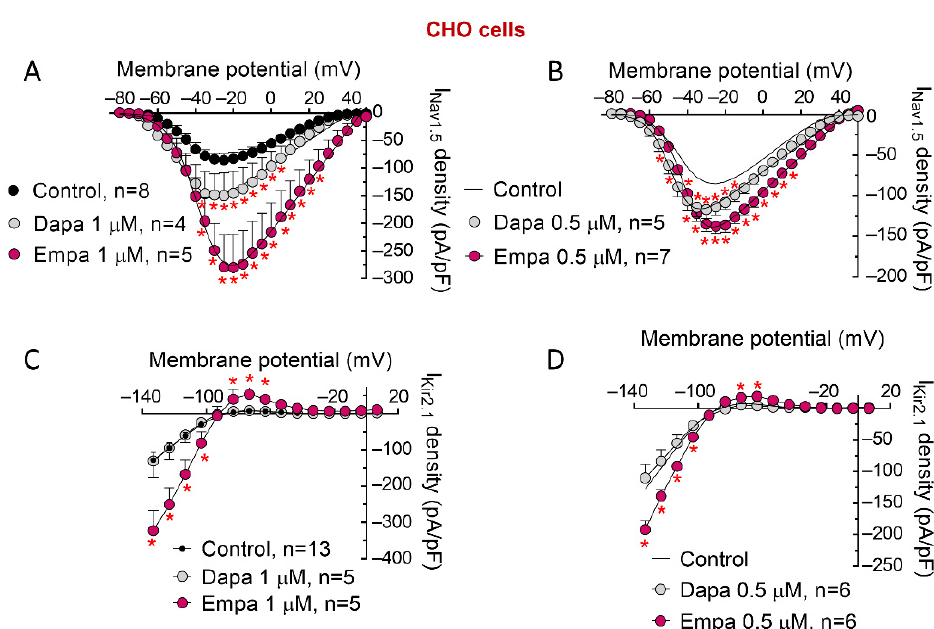
Figure 5. Effects of dapa and empa on I Nav1.5 and I Kir2.1 recorded in CHO cells. ( A , B ) I Nav1.5 density– voltage relationships for currents recorded in CHO cells transiently transfected with human Nav1.5 channels incubated with dapa or empa at 1 ( A ) or 0.5 µ M ( B ) or not incubated. ( C , D ) I Kir2.1 density– voltage relationships for currents recorded in CHO cells transiently transfected with human Kir2.1 channels incubated with dapa or empa at 1 ( C ) or 0.5 µ M ( D ) or not incubated. Each point is the mean ± SEM of the “n” experiments indicated in the figure. * p < 0.05 vs. control.